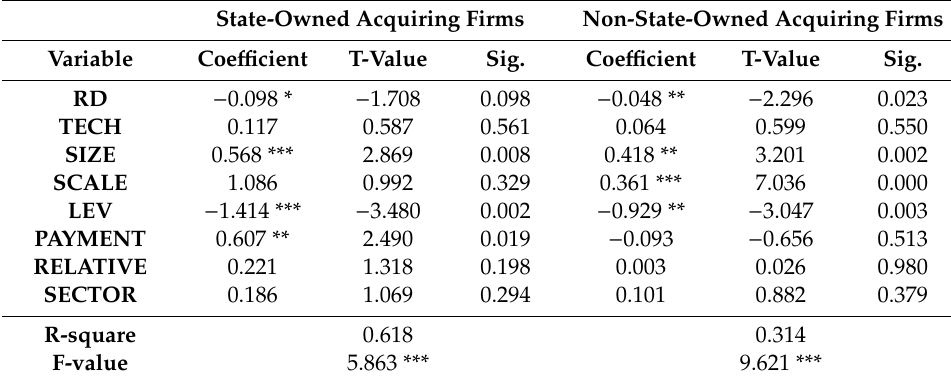
Table 7. Regression results of Model